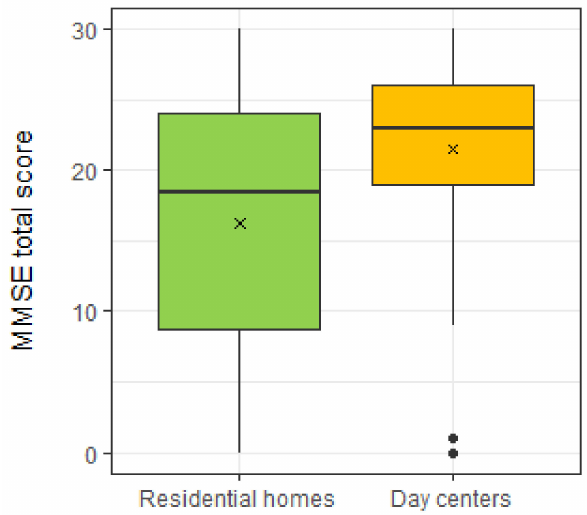
Figure 1. MMSE total score for two groups (RH e DC). The symbol x represents the mean and the black dots the outliers.